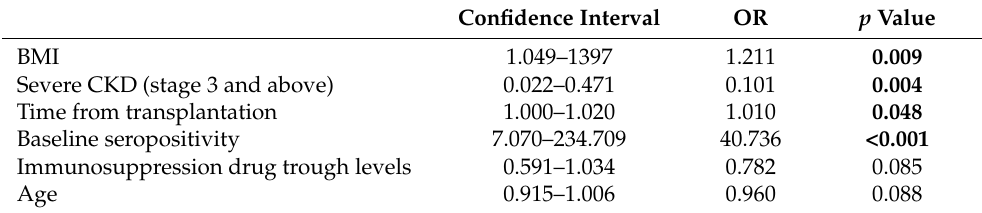
Table 2. Multivariate analysis for seropositivity following the third vaccine